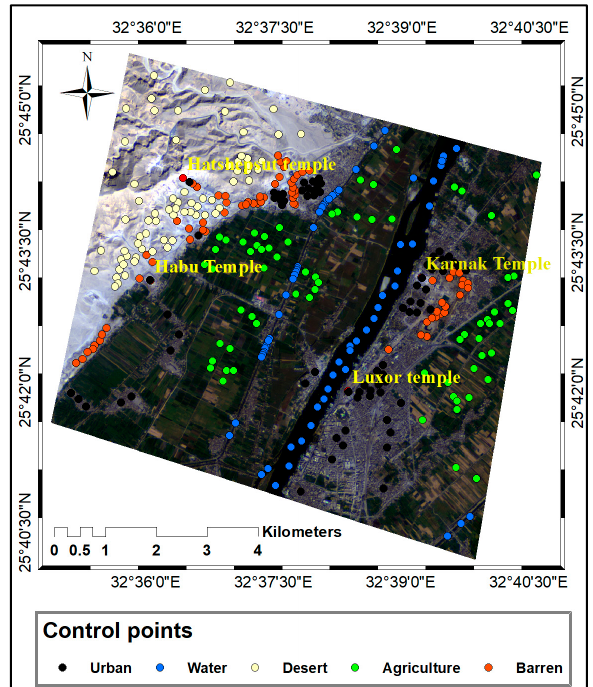
Figure 11. Control points used for Sentinel-2A (20 February 2017) RGB 4,3,2.